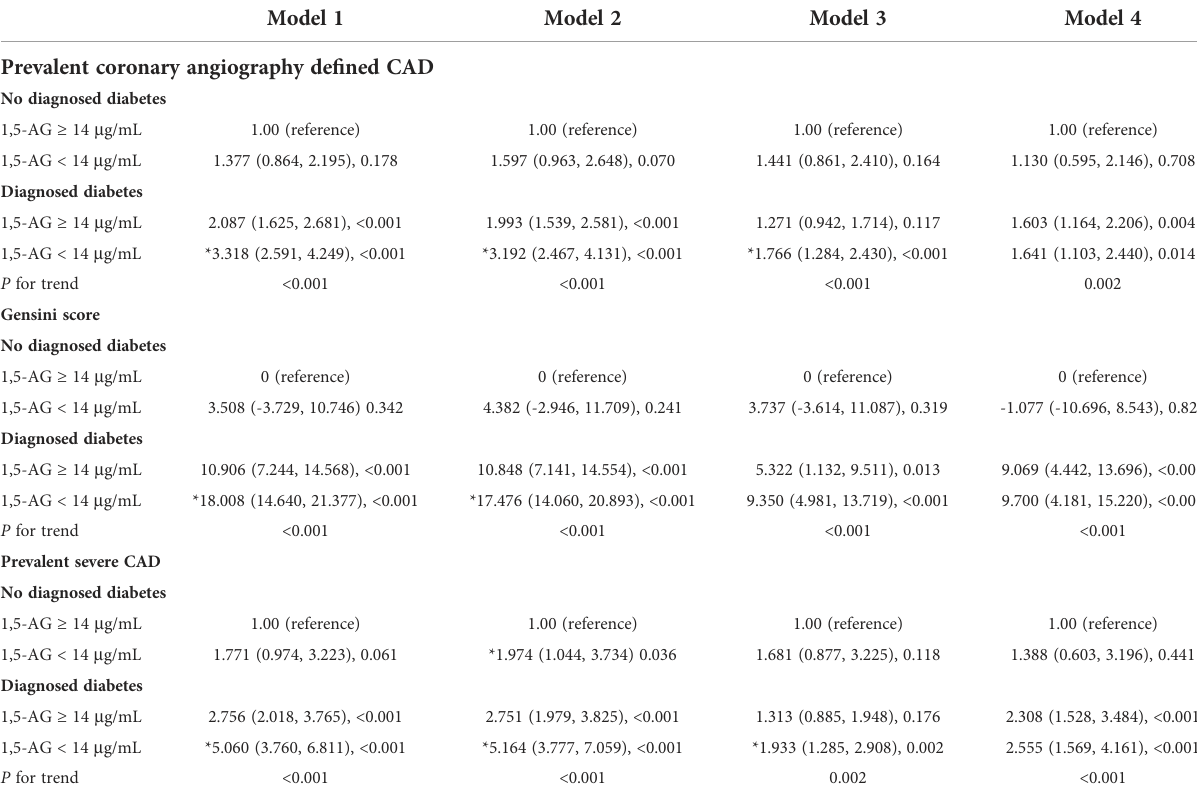
TABLE 3 Adjusted b /OR (95% CI) and p-value of baseline diabetes-speci fi c categories of 1,5-AG with prevalent coronary angiography de fi ned CAD, Gensini score and severe